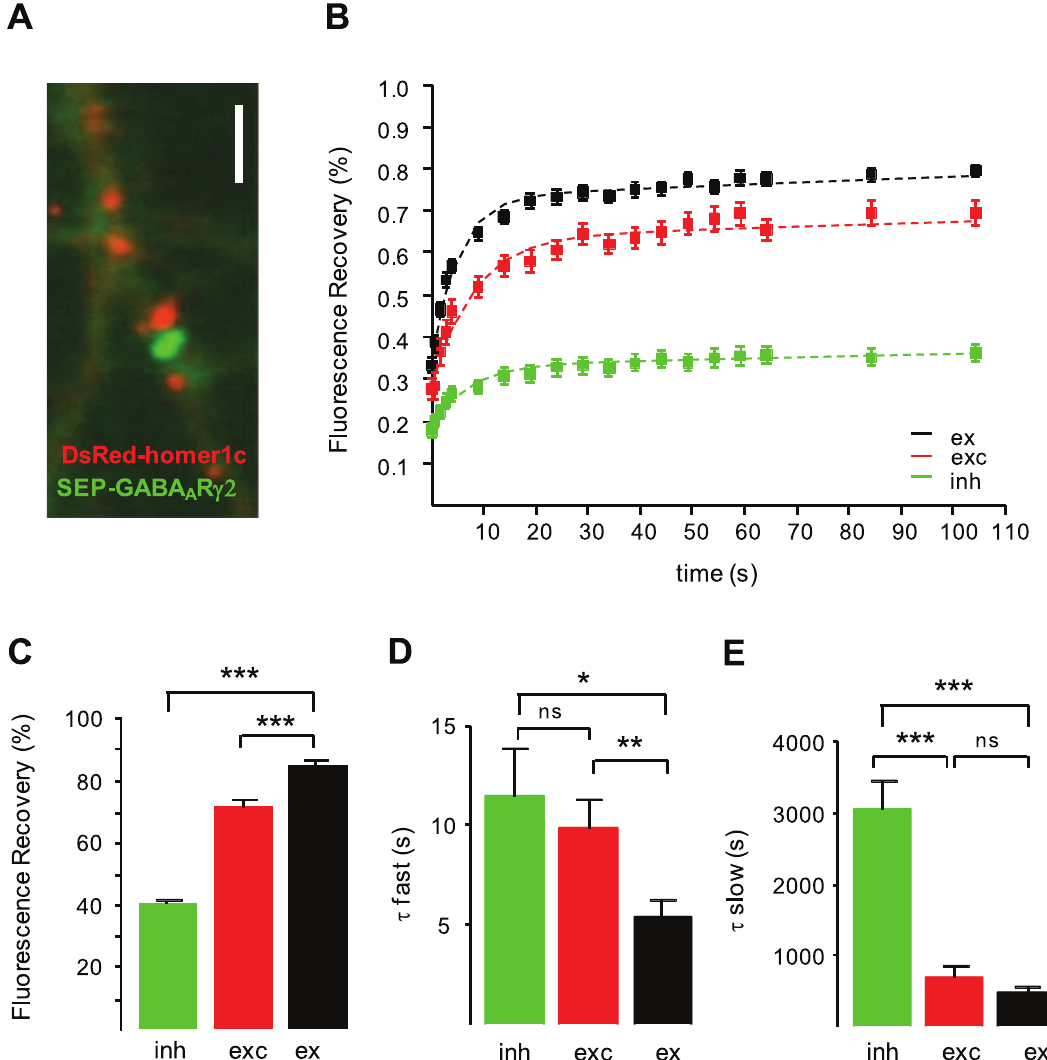
Figure 4. Fluorescence recovery after photobleaching experiments of SEP-GABA A R c 2 at excitatory and inhibitory synapses. (A) Dendritic portion of a neuron co-transfected with SEP-GABA A R c 2 (green) and DsRed-homer1c (red) constructs. Scale, 1 m m. Note that SEP-GABA A R c 2 (green) form clusters that are not colocalized with DsRed-homer1c (red) fluorescent clusters. (B) Normalized SEP-GABA A R c 2 FRAP fluorescence recovery curves at inhibitory synapses (green, inh), excitatory synapses (red, exc), and in extrasynaptic compartment (black, ex). (C) Percentage (mean 6 SEM) of SEP- c 2 fluorescence recovery at inhibitory synapses (inh, green), excitatory synapses (exc, red) and extrasynaptically (ex, black). Note the increase in the size of the pool of slowly mobile c 2 at excitatory synapses as compared with the extrasynaptic compartment (t-test, ***p , 10 2 3 ). (D–E) Time constants (mean 6 SEM) for the fast (D) and slow (E) pool, obtained from the double exponential fit (see Materials and Methods) applied to the data in B for inhibitory (green, inh), excitatory (red, exc) synapses or extrasynaptic area (black, ex) (t test, ns: not significant, *: p , 0.05, **: p , 0.01; ***: p , 0.001).